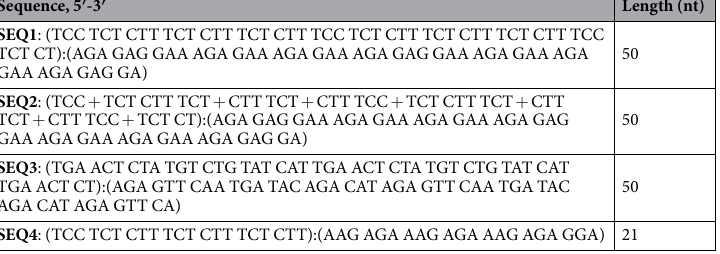
Table 1. Synthetic dsDNA used in this study * . * Pluses indicate LNA modifications.